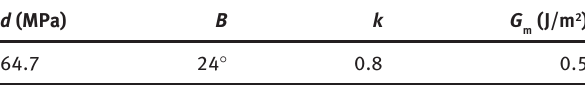
Table 2: Material parameters of the matrix.